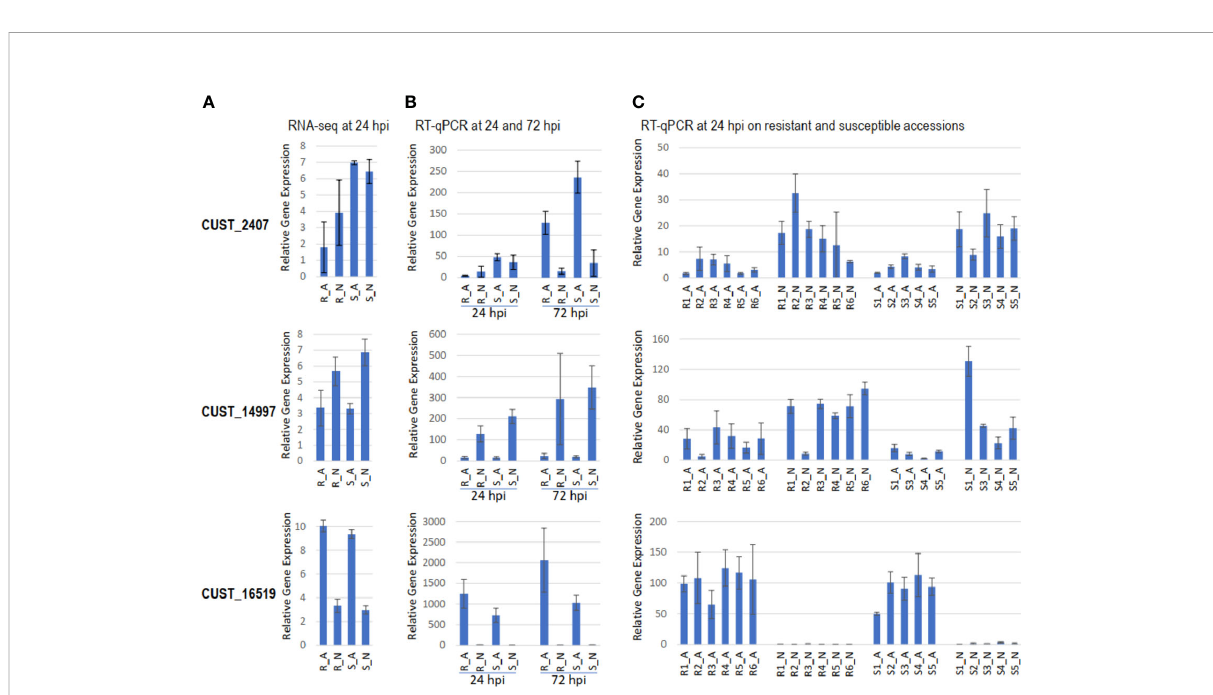
FIGURE 5 Gene expression level of RxLR genes CUST_2407, CUST_14997 and CUST_16519 in different host-isolate interactions. Barplot of (A) the TMM- normalized gene expression measured by RNA-seq in hosts R and S at 24 hpi. Barplot of gene expression measured by RT-qPCR relative to the expression of the housekeeping gene Ubc (B) in hosts R and S at 24 and 72 hpi, and (C) in six resistant lines [R1 (PM0217/PI201234), R2 (PM0659/ Perennial), R3 (PM0702/CM334, R), R4 (PM1407/Phyo 636), R5 (PM1409/Vania), R6 (PM1686/Breeding Line B2)] and fi ve susceptible lines [S1 (PM0031/Yolo Wonder, S), S2 (PM0076/Doux Long des Landes), S3 (PM0807/H3), S4 (PM0867/(Meskix872)AP1-B1), S5 (PM0972/Quadrato d ’ Asti rouge)] of pepper at 24 hpi. The same pro fi les of expression measured by RT-qPCR was observed with the reference genes Ppi2 and RL13 .